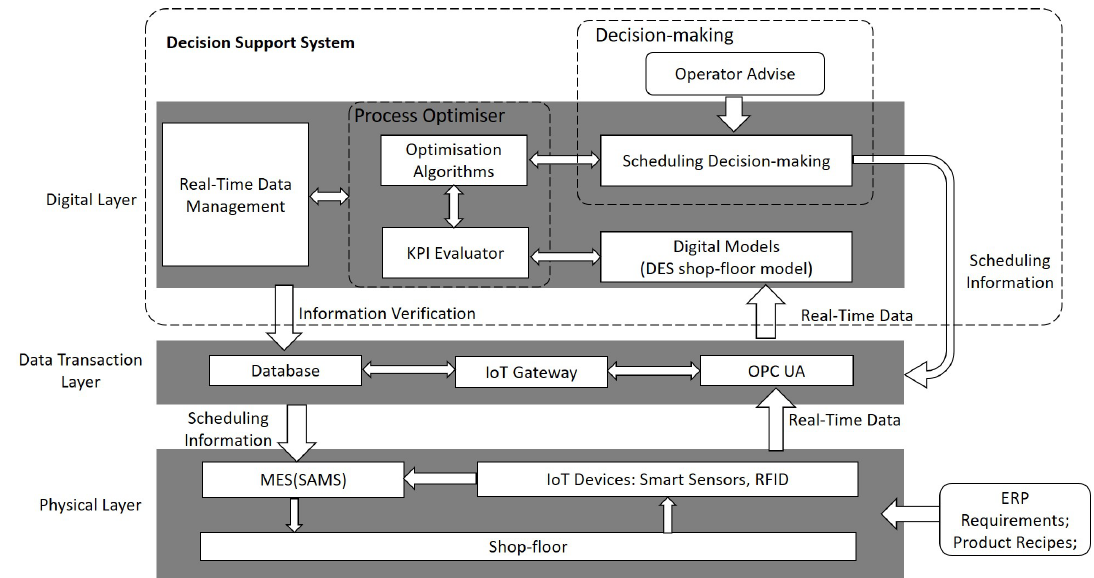
Figure 1. The SAMS